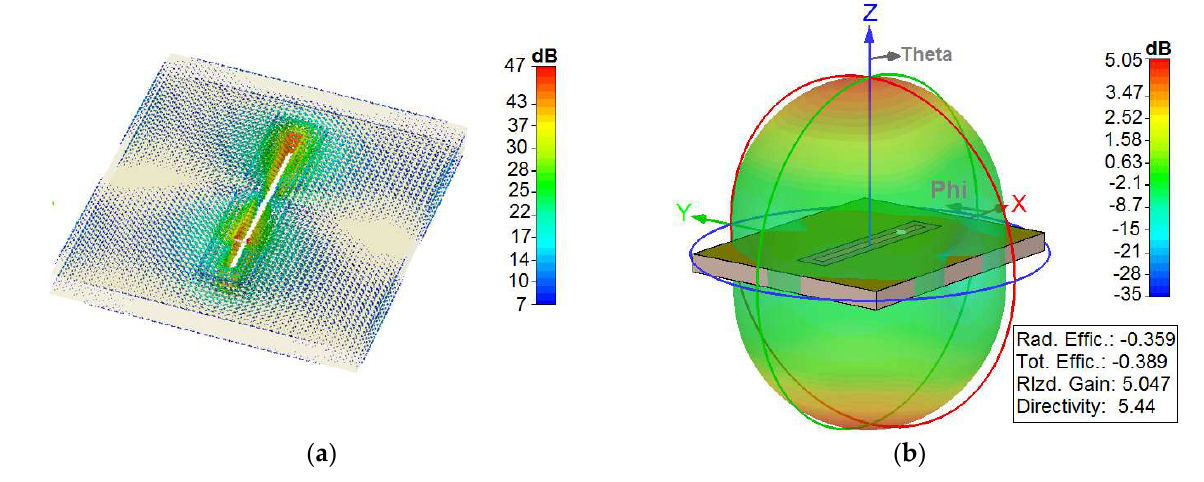
Figure 6. ( a ) The current densities and ( b ) radiation at 22.25 GHz.